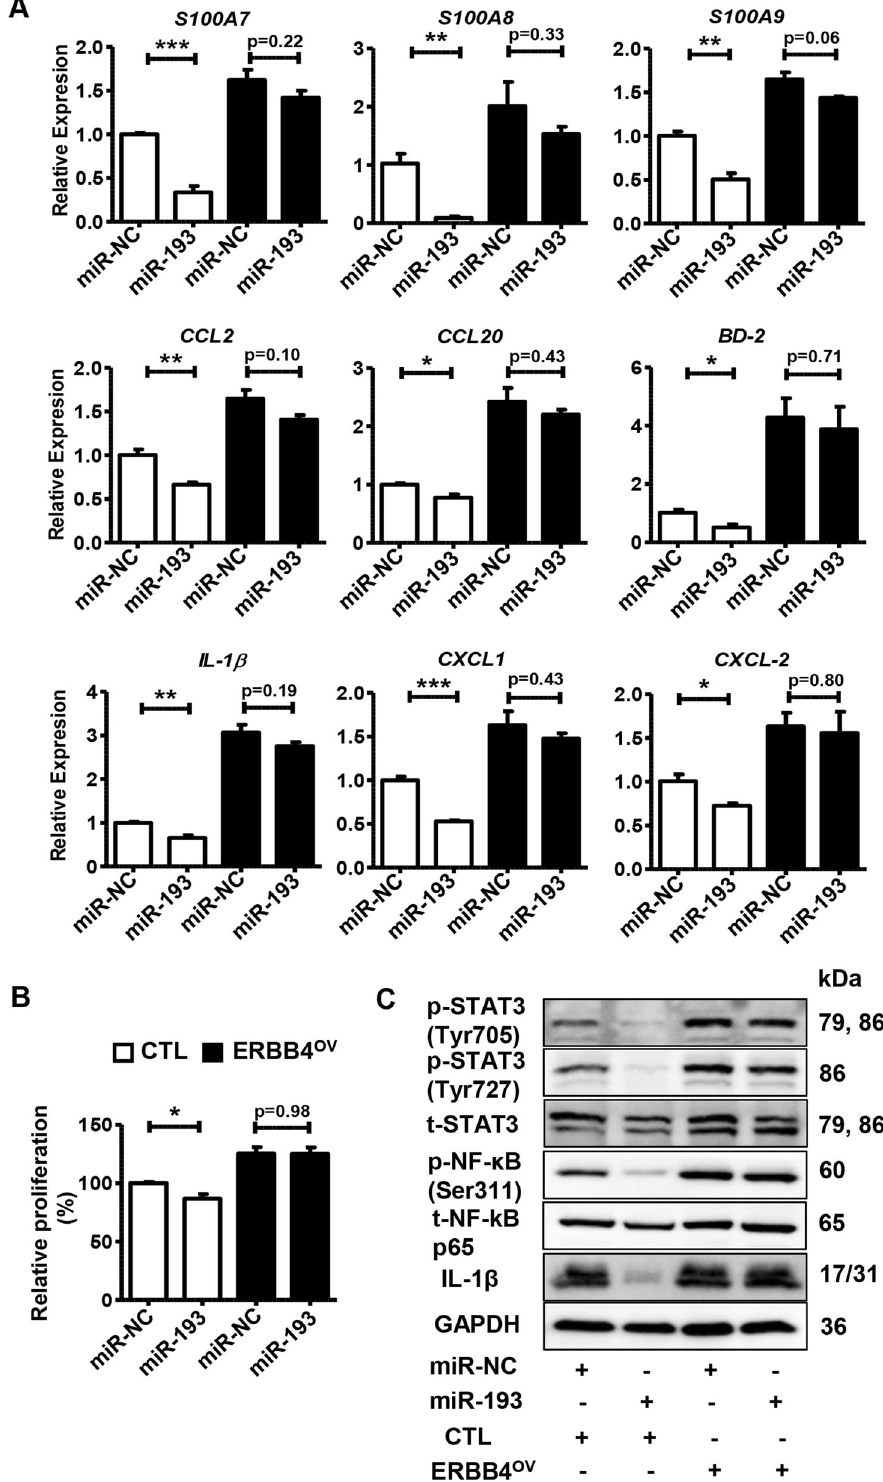
Fig. 8 ERBB4 rescues the inhibitory effects of miR-193b-3p on keratinocytes. A The mRNA levels of psoriasis-related genes and in fl ammatory genes in HaCaT cells co-transfected with miR-193b-3p mimics and ERBB4-overexpression vector (ERBB4 OV ). Cells were collected 2 days after co-transfection and mRNA levels were analyzed using qRT-PCR. GAPDH was used as the internal control. Each bar represents mean ± SEM ( n = 3). *** P < 0.001, ** P < 0.01, * P < 0.05, compared with the indicated controls. B Relative proliferation rate of HaCaT cells co- transfected with miR-193/miR-NC and ERBB4 OV /CTL. Cell proliferation was analyzed using MTT assay. Each bar represents mean ± SEM ( n = 3). * P < 0.05, compared with the indicated controls. C Representative blots showing the levels of phospho-STAT3 (Tyr705), phospho-STAT3 (Ser727), phospho-NF- κ B p65 (Ser311), and IL-1 β in the keratinocytes co-transfected with miR-193/miR-NC and ERBB4 OV /CTL. Protein levels were detected by western blotting. GAPDH was used as a protein loading control.